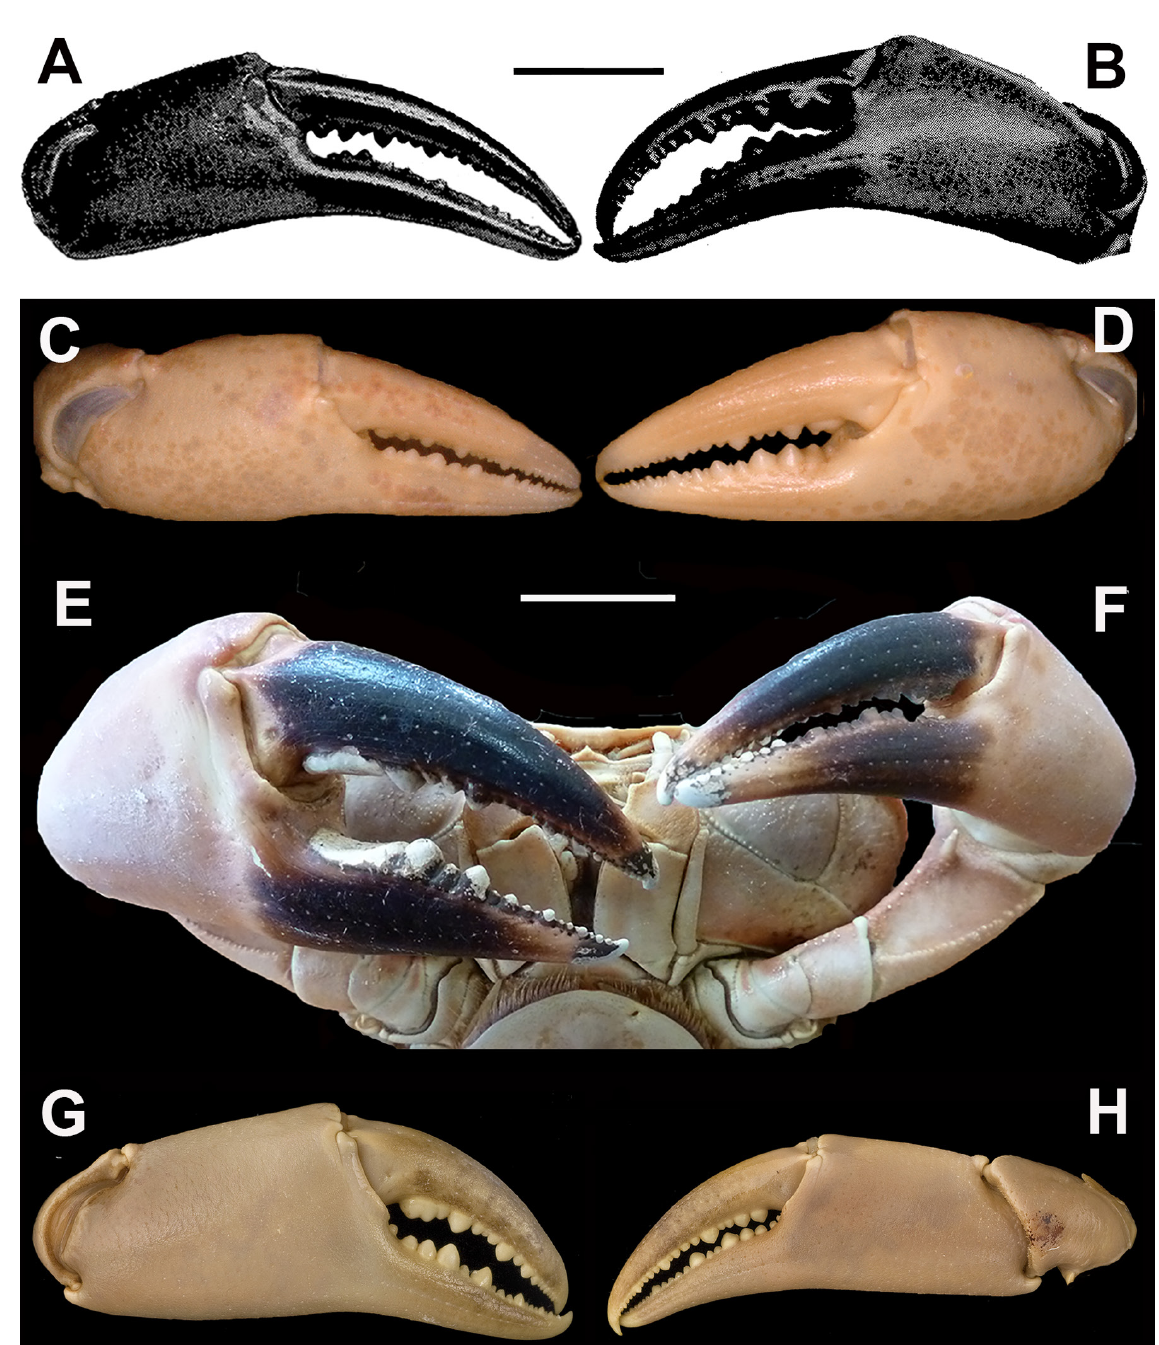
Fig. 6. Outer view of left and right chelae. A–B . Potamonautes kisangani sp. nov., holotype, adult, ♂, CW 60.5 mm, from Kisangani, Democratic Republic of the Congo (USNM 98944). C–D . P. amosae sp. nov., holotype, adult, ♂, CW 46.5 mm, from Lake Kivu, D.R. Congo (NHMUK 2018.306). E–F . P. amosae sp. nov., adult, ♀, CW 80.1 mm, from the Malagarasi River, Tanzania (NMU TRW 1971.05). G–H . P. orbitospinus (Cunnington, 1907), lectotype, adult, ♂, CW 56.9 mm, from Nkhata Bay, Lake Malawi, Malawi (NHMUK 1908.1.31.27). Scale bars: A–B = 10.9 mm; C–D = 8.9 mm; E–F = 11.0 mm; G–H = 8.9 mm. Photographs G–H by Phillip Crabb,